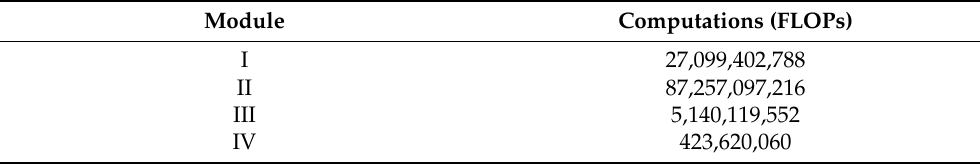
Table 2. The computational cost of different modules of the proposed deblurring architecture.